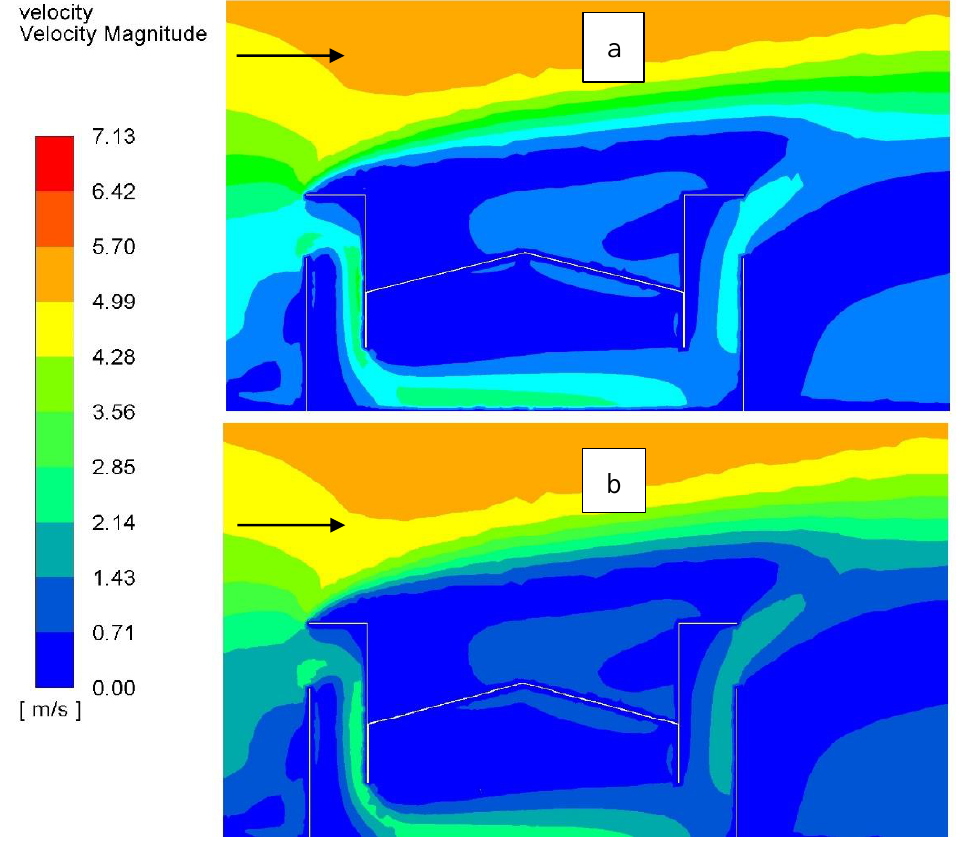
Figure 18. ( a ) Velocity contour at the midplane of the greenhouse—four parallel sprays. ( b ) Velocity contour at the midplane of the greenhouse—eight parallel sprays (ambient T = 40 °C, RH = 24.5%, U HWC = 4.4 m/s).